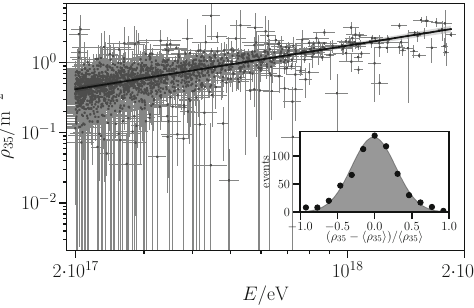
Fig. 10 Muondensities ρ 35 asafunctionoftheenergy.Thedistribution of the normalized residuals (ρ 35 −(cid:14) ρ 35 (cid:15) ) / (cid:14) ρ 35 (cid:15) is shown in the inset